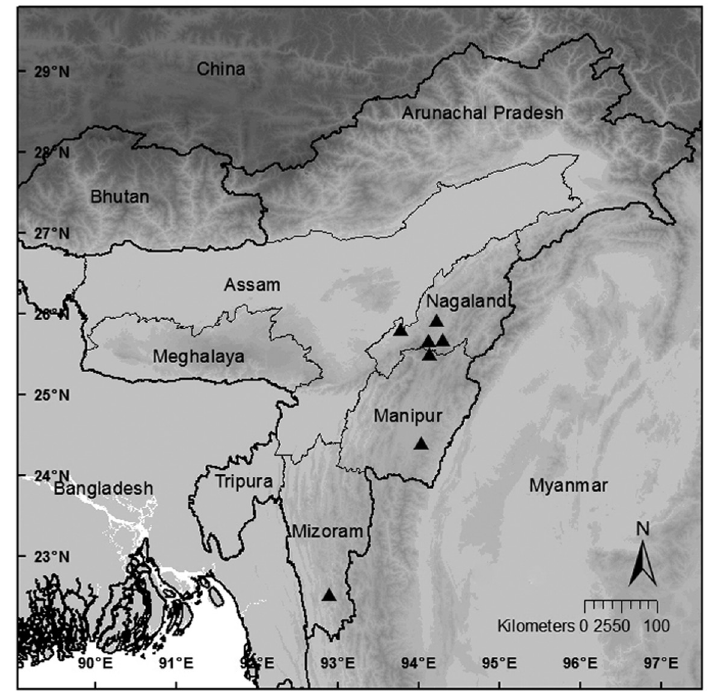
Fig. 61. Map showing the location of B. wattii C.B.Clarke